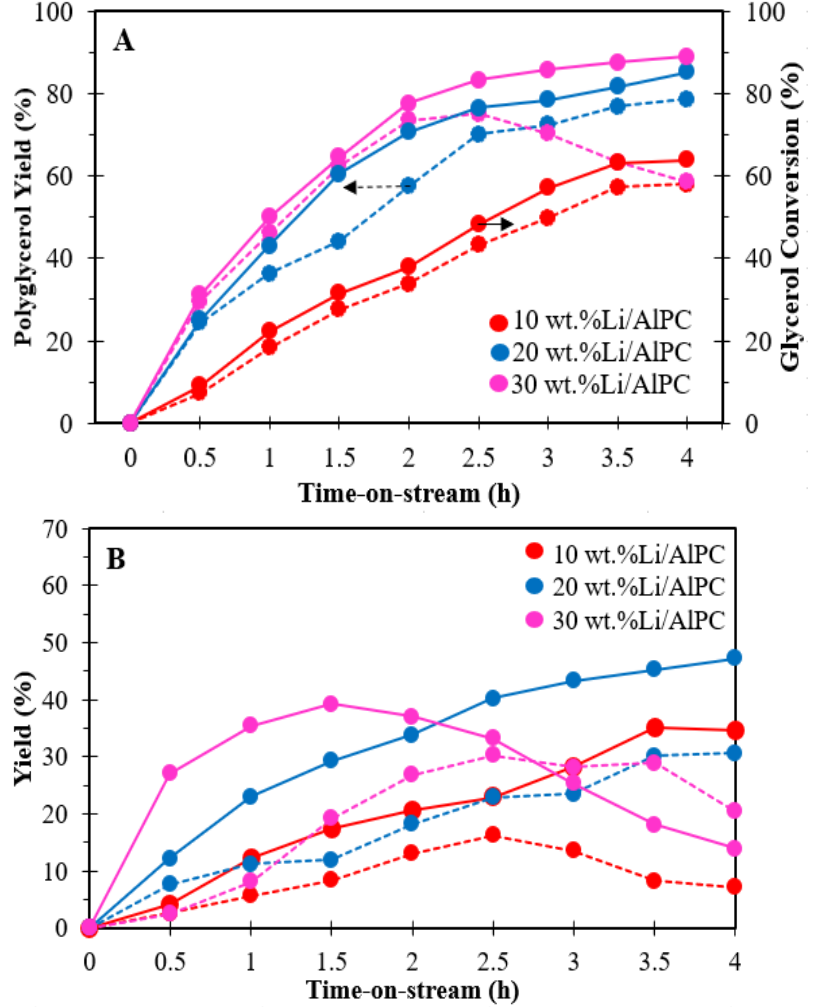
Figure 7. ( A ) Conversion of glycerol to polyglycerol and ( B ) short-chain oligomers (solid line: diglycerol, dotted line: triglycerol) formation in the presence of 2 wt.% catalyst at 200 °C.